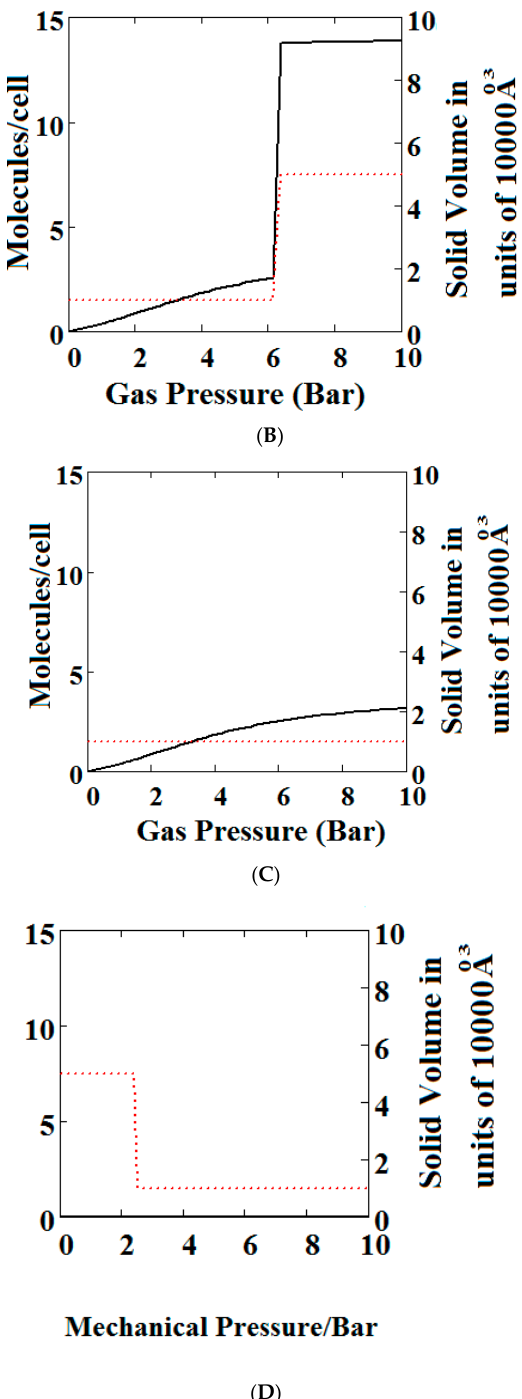
Figure 6. Plot of the behaviour of the methane adsorption in the theory MOF under an additional applied mechanical pressure of ( A ) 0 Bar; ( B ) 10 Bar; ( C ) 100 Bar. In ( B , C ) the NGA transformation shown in ( A ) has disappeared. The dotted red curve on the secondary right axis indicates the NP/LP state of the MOF; ( D ) Plot of the density behaviour of the MOF under an applied compressive stress. The dotted red curve on the secondary right axis indicates the NP/LP state of the MOF. The other parameters are T = 285 K, uglp = − 29.1 kJ/mole, ugnp = − 28.69 kJ/mole, J = − 1.66 kJ/mole, ∆ = 5.8 kJ/mole, X = 10,000 Å 3 , Y = 50,000 Å 3 , Nm = 10, scale = 0.85, nmaxlp = 4, nmaxnpb = 4.